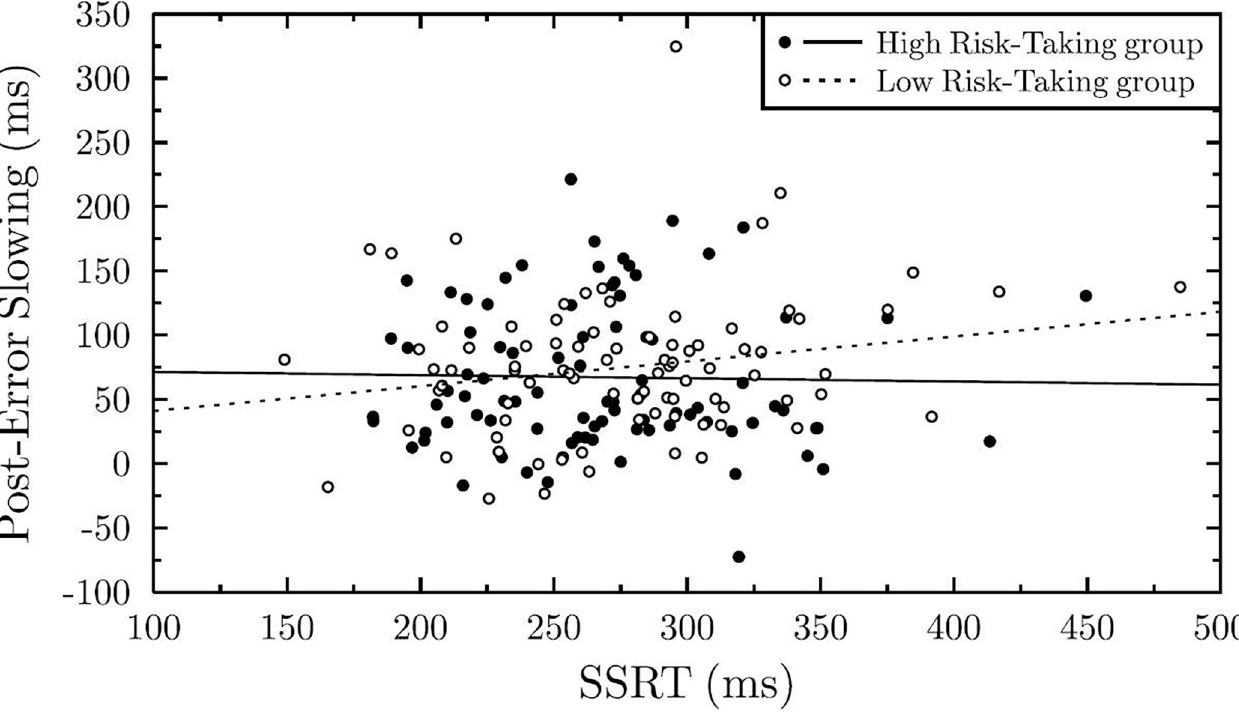
Fig 2. Proactive behavioral adjustments as a function of reactive inhibition capacity and risk-taking propensity. The SSRT (Stop Signal Reaction Time) was used as an index of reactive inhibition capacities. The PES (Post-Error Slowing) was used as an index of proactive behavioral adjustments. The risk-taking groups were created for visualization purpose only. We used the median of the RTI (Risk-Taking Index, the mean duration of the button-press at the BART task) distribution to categorize participants as high ( N = 87) or low risk-takers ( N = 86).